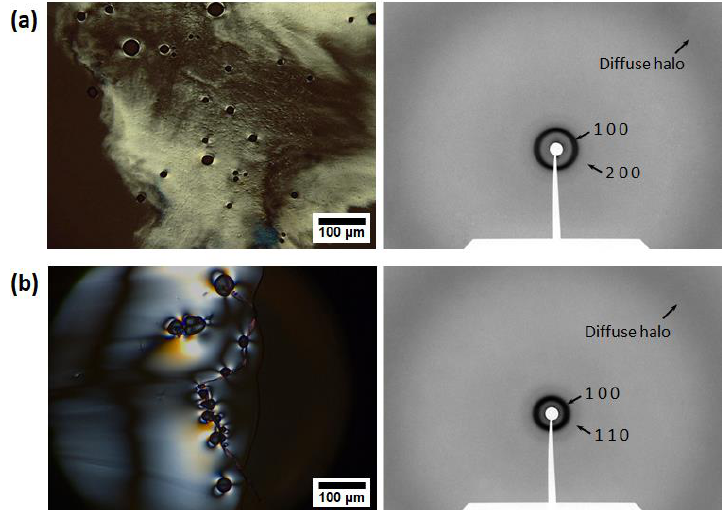
Figure 2. POM microphotographs ( left ) and X-ray diffraction (XRD) patterns ( right ) taken at room temperature for: ( a ) PAMAM16– cov –ChCou and ( b ) PAMAM64– cov –ChCou .